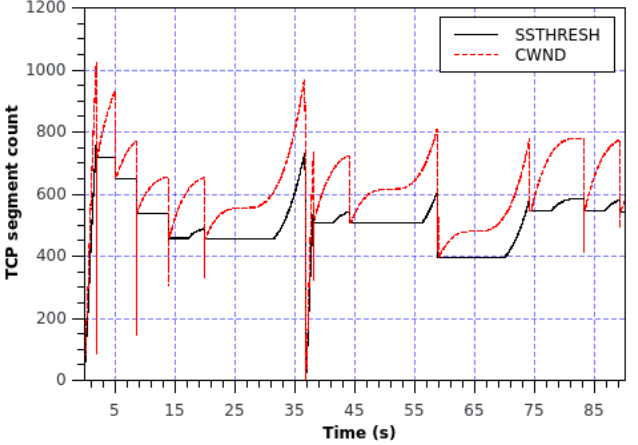
Figure 18. Slow start threshold and congestion window on TCP sender with an unmodified Linux kernel.